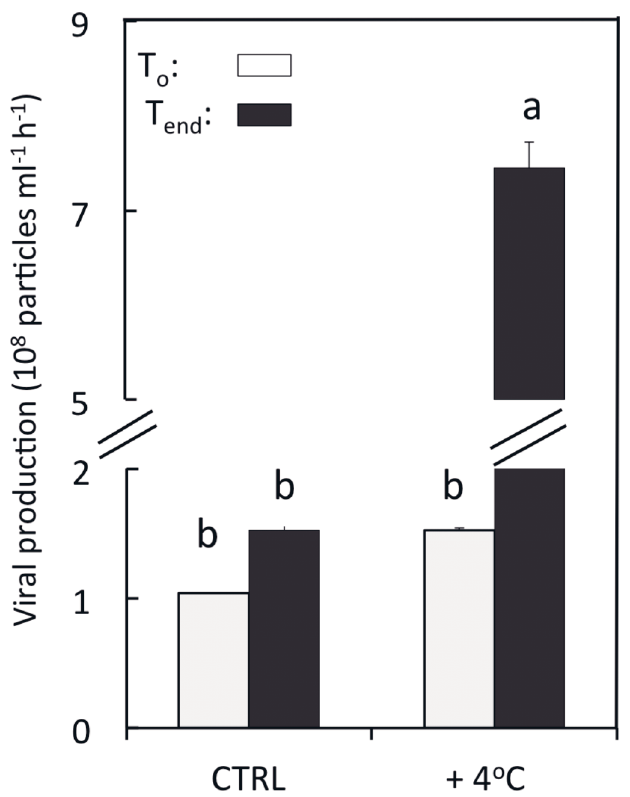
Figure 3. Viral lytic production in mucus samples of F. repanda in both control (CTRL) and heat-treatment (+4 °C). Error bars represent one standard deviation from the mean ( n = 3). Histograms with the same letters are not significantly different at p =